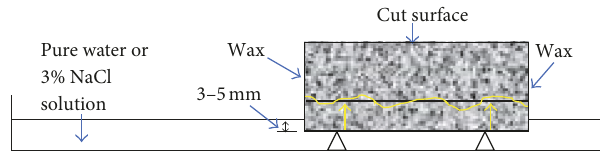
Figure 4: Schematic illustration for water absorption and chloride penetration test of